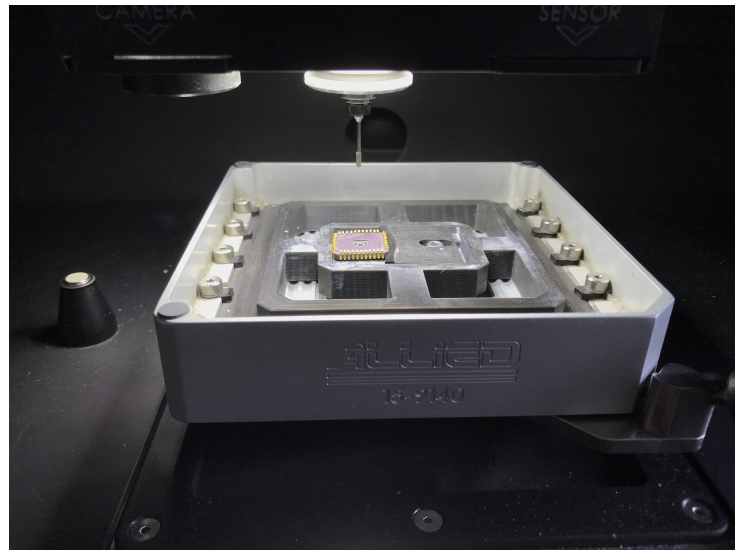
Figure 5: Preparation of an ASIC sample for the LFI experiments using an X-Prep precision milling